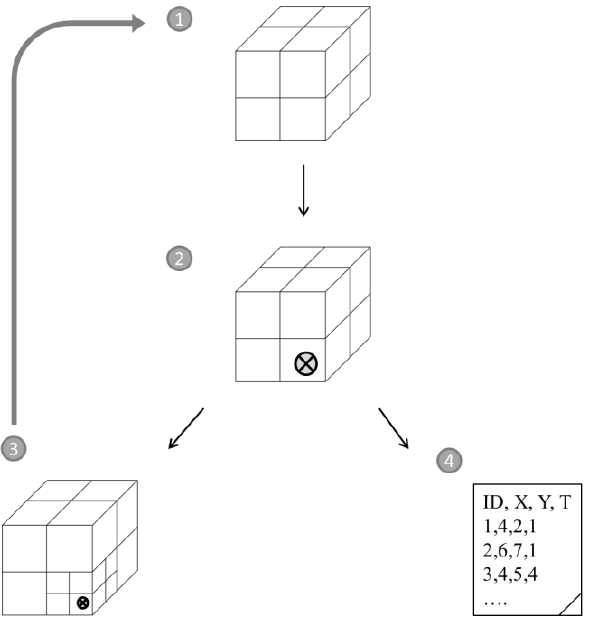
Figure 1: Steps of the recursive octtree-based spatiotemporal domain decomposition algorithm.